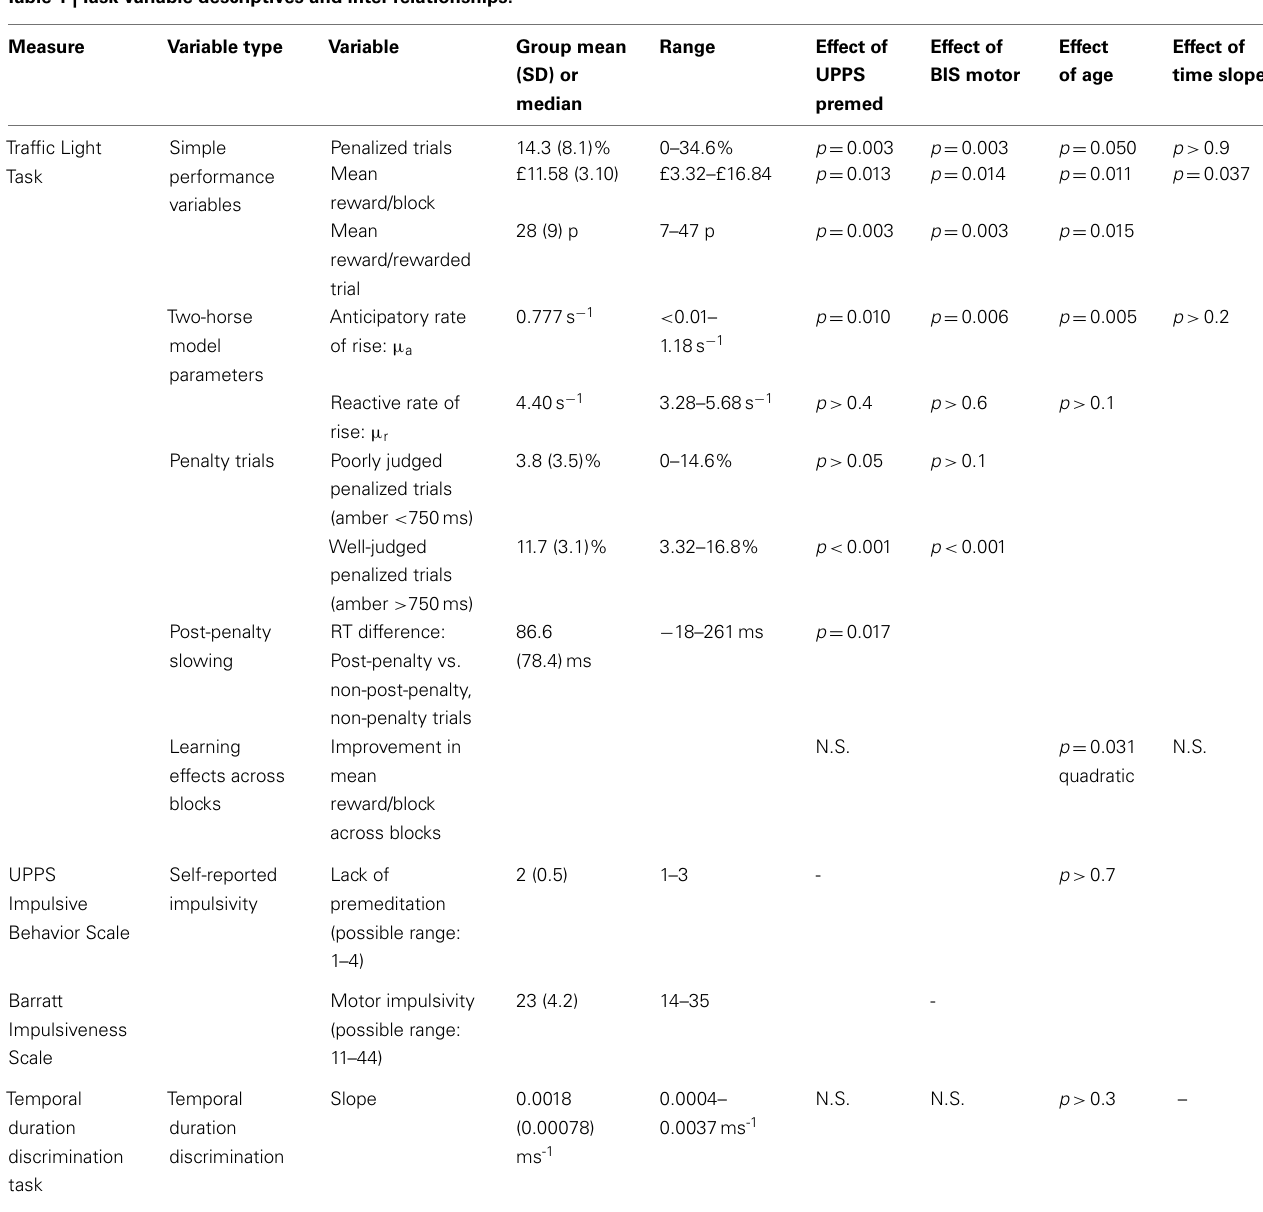
Table 1 |Task variable descriptives and